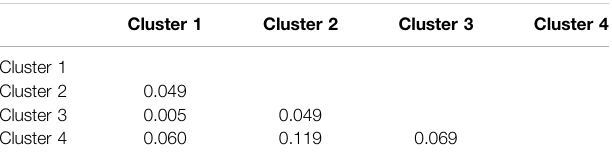
TABLE 10 | Pairwise F ST estimates between